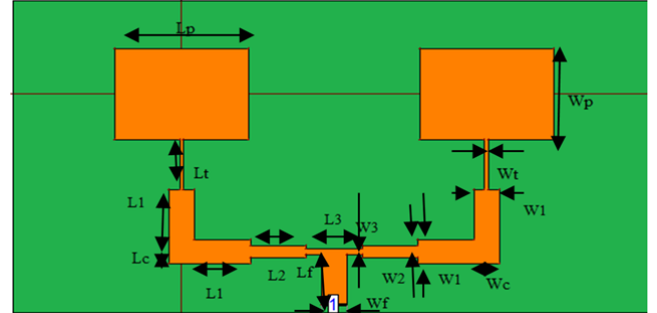
Figure 1. Schematic of conventional microstrip antenna array.